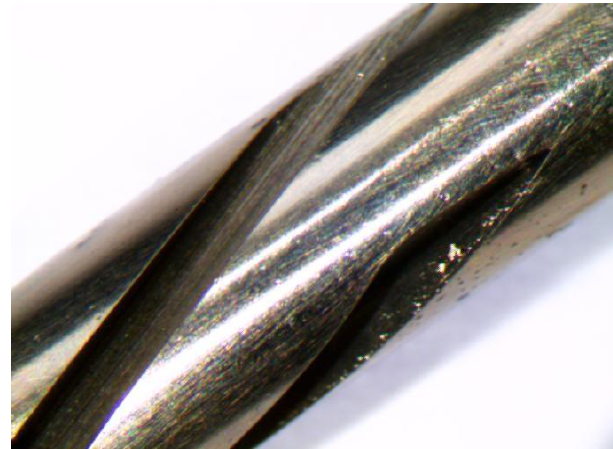
Fig. 4. Longitudinal delineation on the needle